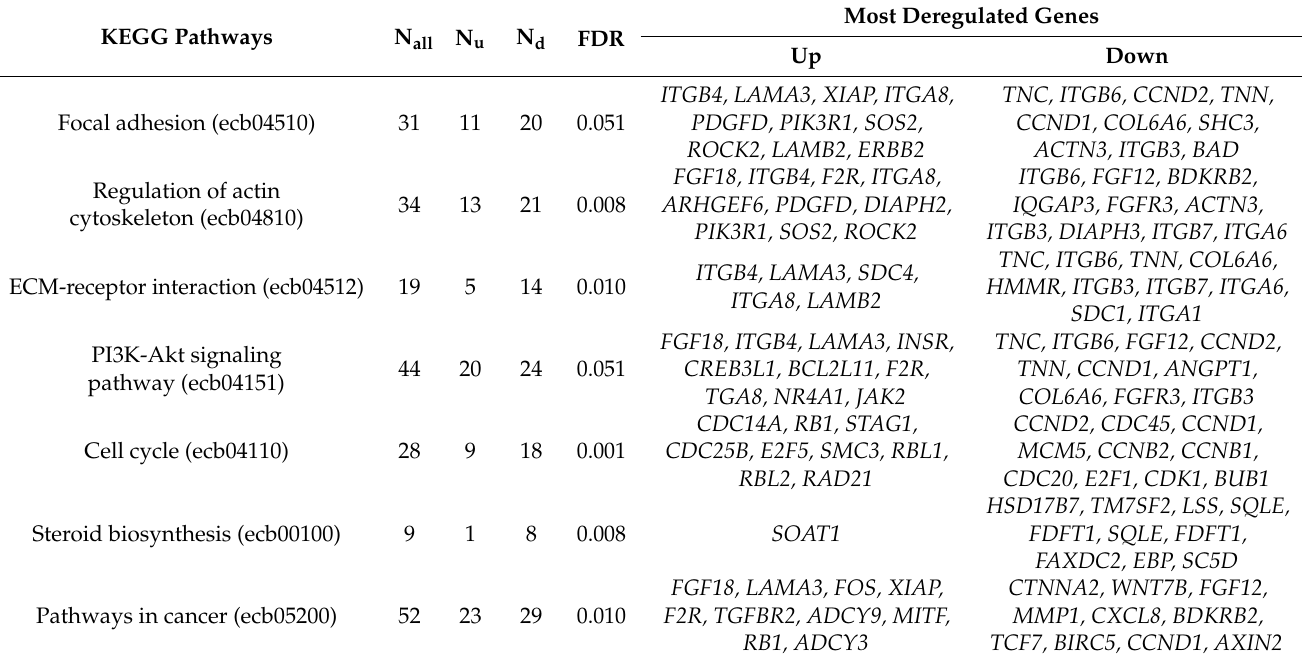
Table 3. The significant enrichment in molecular KEGG pathways detected on the basis of compara- tive analysis of DEGs set between BPV-E4 and control